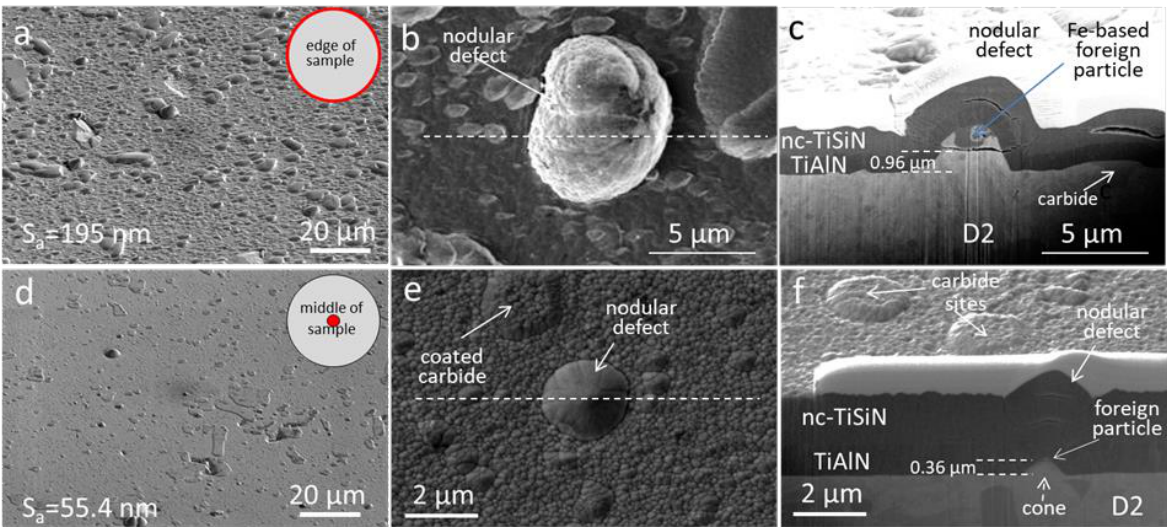
Figure 17. SEM images of the nanostructured hard coating TiAlN/TiSiN/TiAlSiN deposited in the CC9 deposition system: ( a – c ) at the edge and in ( d – f ) the middle of D2 round substrate. The SEM images ( a , d ) are the side view from about 45° inclined direction. Top view SEM images in the middle show selected nodular defects ( b , e ) and their FIB cross section ( c , f ). A step formed under the seed particles (marked with dashed lines) shows that a 3-times thicker layer was removed on the edge during ion etching in comparison with the middle of the substrate.